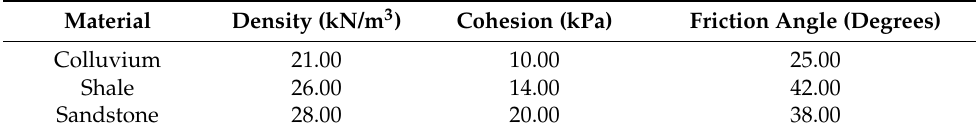
Table 17. Results obtained from the stability analysis considering the 16 critical profiles. Critical